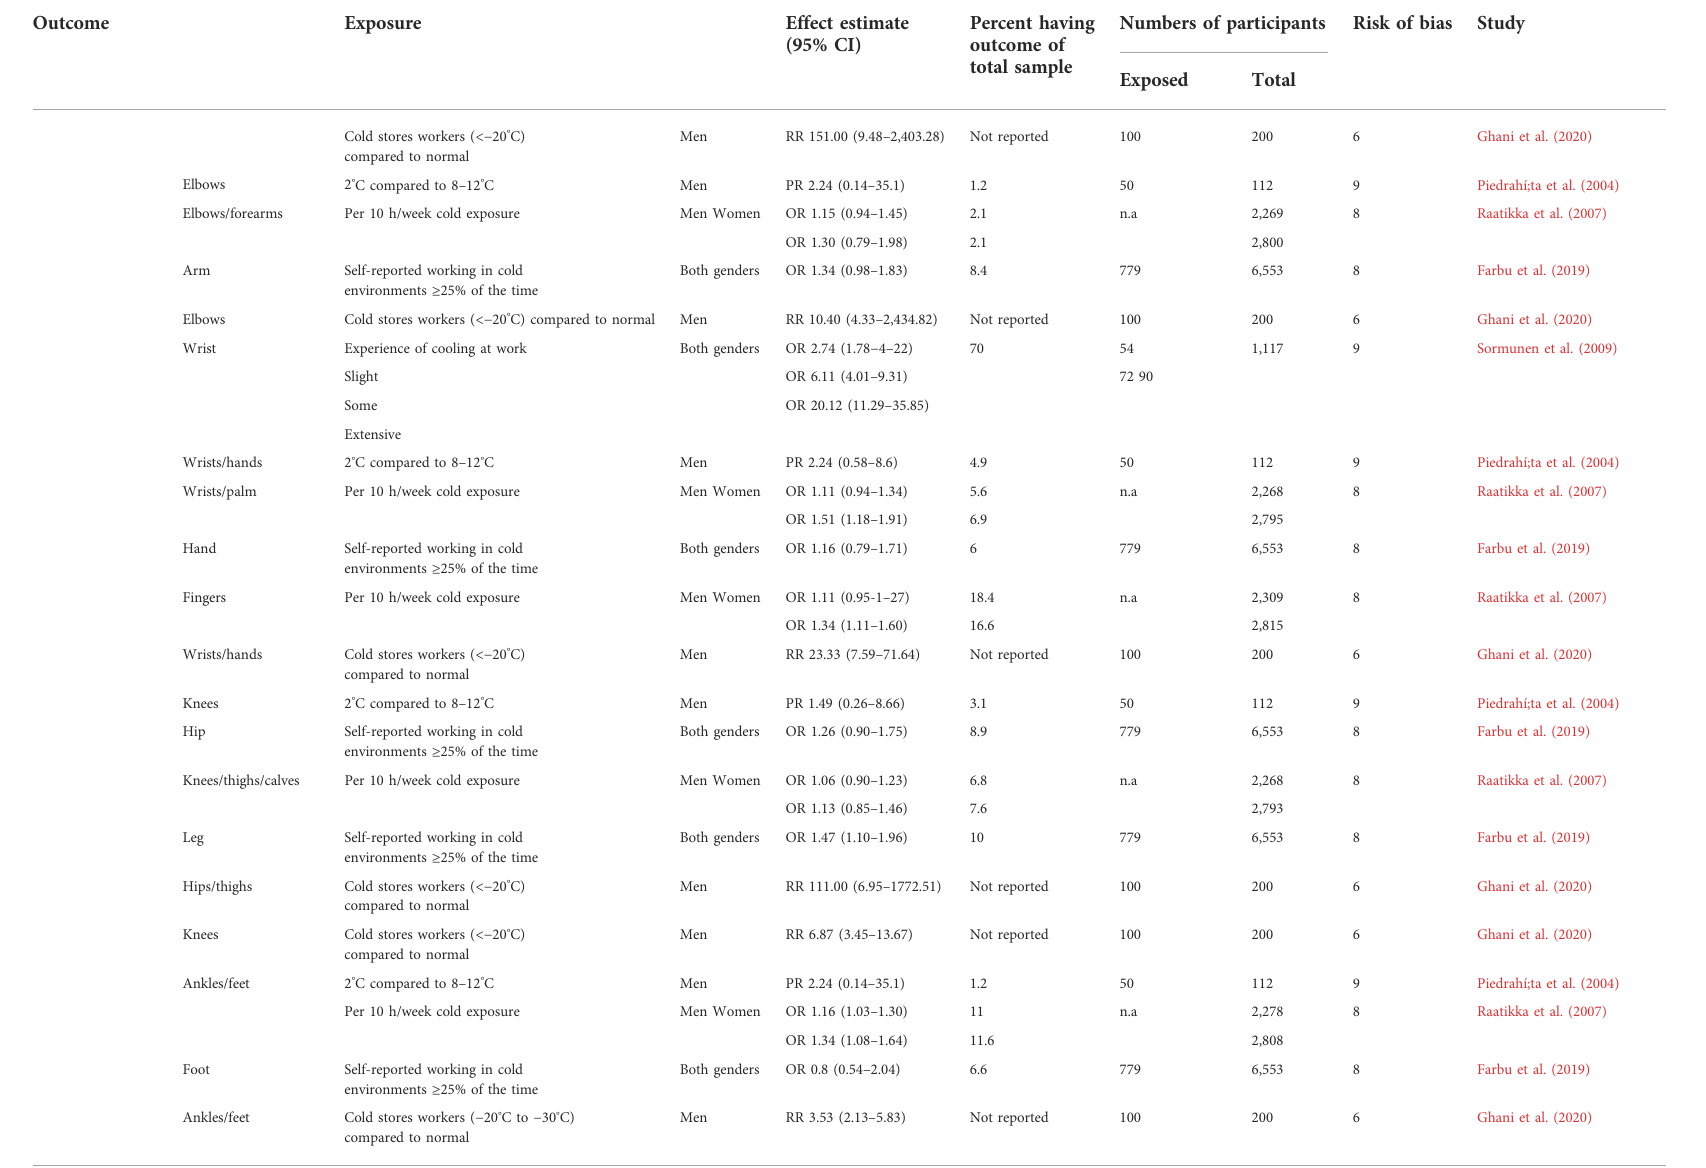
TABLE 3 ( Continued ) Effect estimates sorted after type and type of assessment of pain or regional pain.